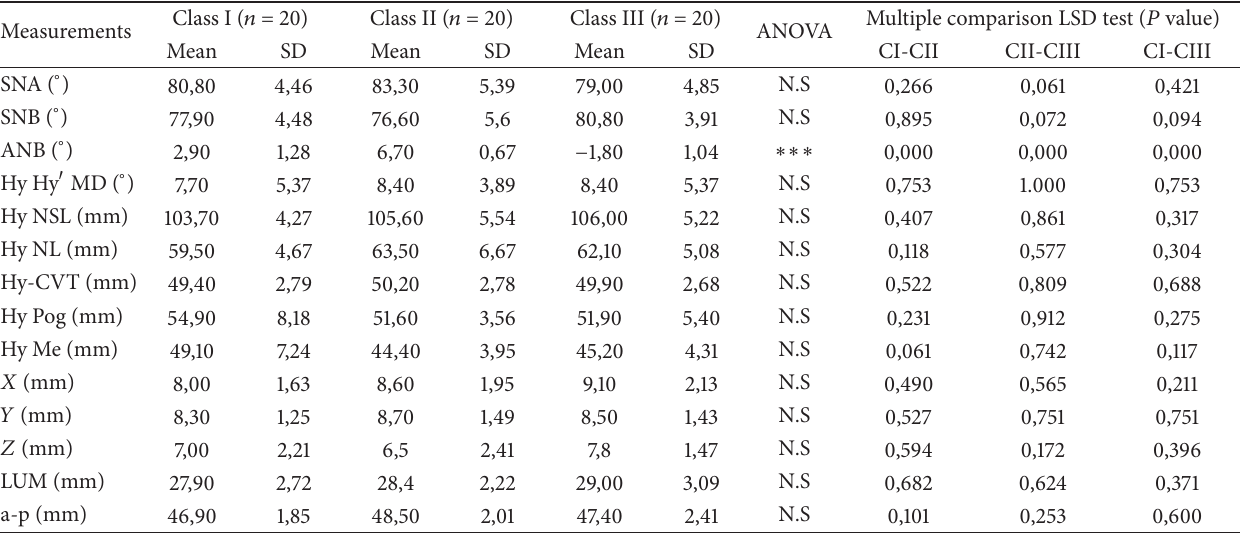
Table 6: Intergroup comparison of mean differences among females with Class I, II, and III skeletal patterns.